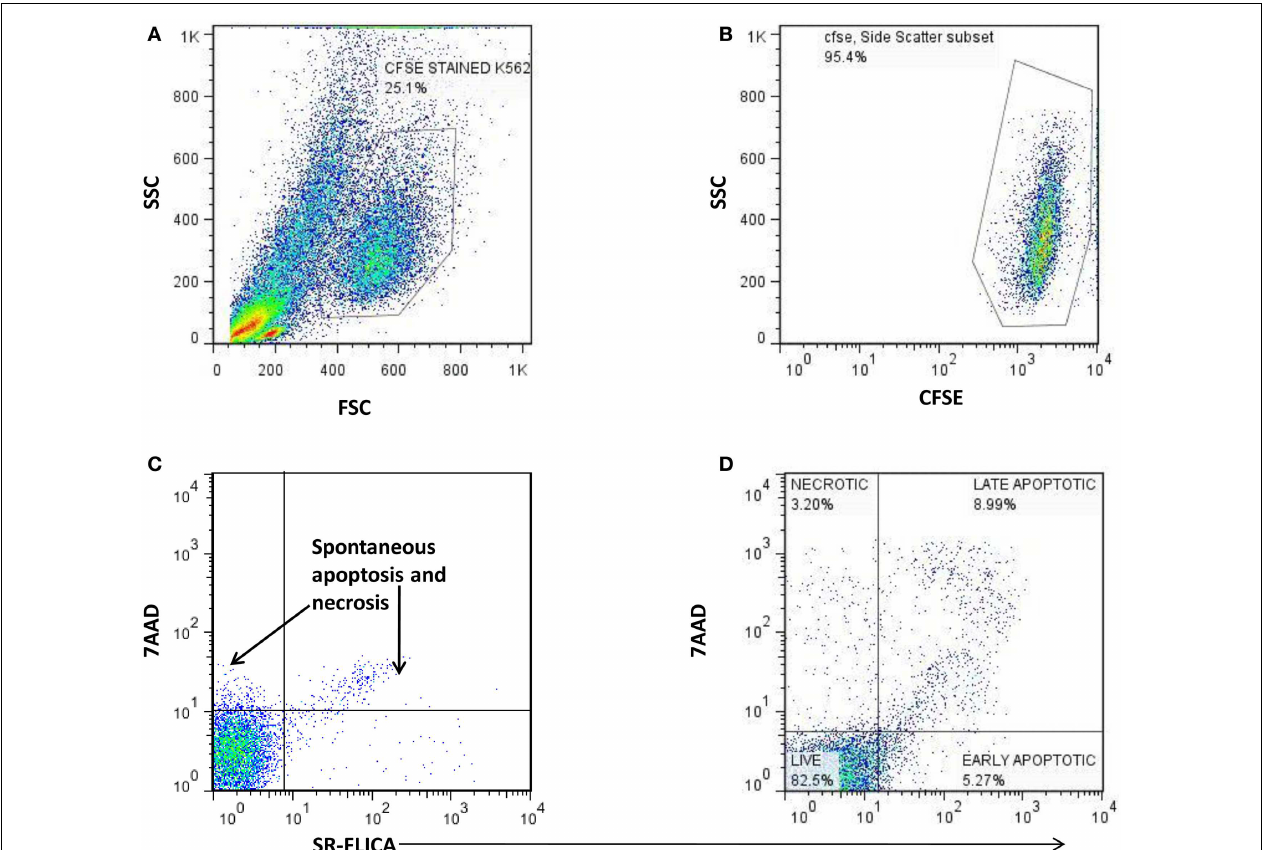
of K562 cells: (Negative control): CFSE stained K562 cells alone incubated for 4h. (D) Lysis of CFSE stained K562 cells by the effector cells: 7AAD X axis) vs. SR-FLICA ( Y axis) showing necrotic (7AAD + SR-FLICA − : upper left quadrant), late apoptotic (7AAD + SR-FLICA + : upper right quadrant), and early apoptotic cells (7AAD − SR-FLICA + : lower right